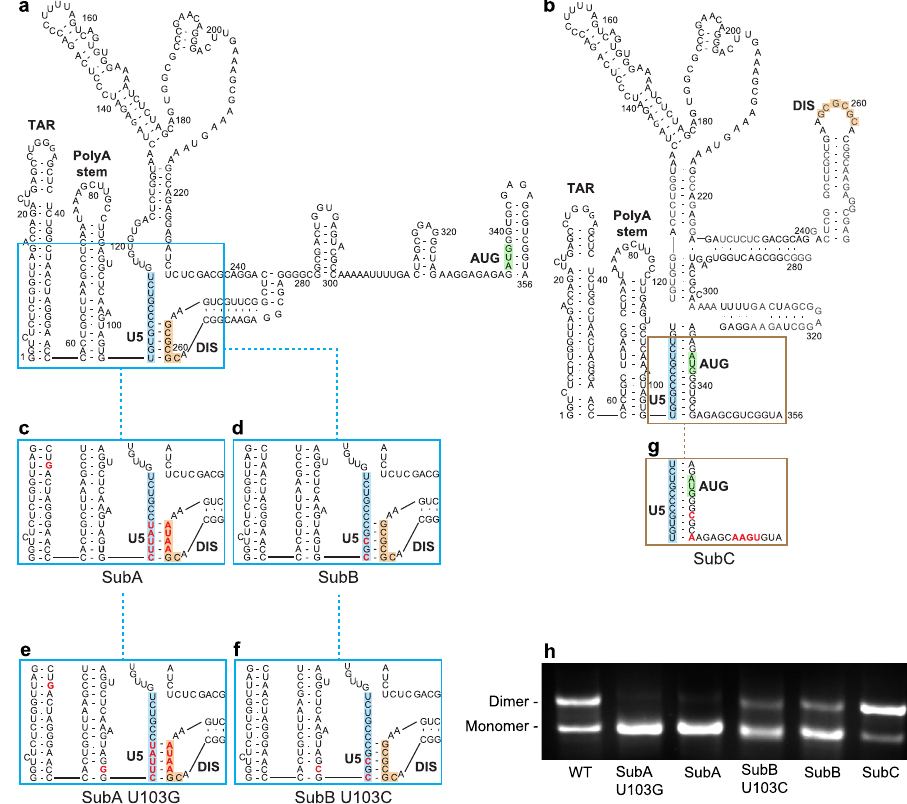
Figure 1. Models of the HIV NL4-3 5 ′ UTR conformations with select nt substitutions to alter monomer-dimer equilibrium. Models of HIV NL4-3 5 ′ UTR ( + 1 to 356) ( a ) monomer and ( b ) dimer structures from Lu et al . 10 . Labels designate: TAR, PolyA stem, U5 (blue), DIS (orange), AUG (green), and nt substitutions (red). Boxes highlight sequences proximal and distal to U5 involved in monomer (blue) or dimer (brown) conformations. ( c and d ) SubA and SubB contain nt changes that favor U5:DIS base-pairing and destabilize U5:AUG base pairing. ( e and f ) Additional U103 substitutions destabilize the bottom stem of PolyA in SubA U103G and SubB U103C. ( g ) SubC contains nt substitutions that favor U5:AUG base-pairing and maintain amino acid conservation without rare codon bias. ( h ) Native agarose gel assay shows 5 ′ UTR conformations in vitro at equilibrium. WT 5 ′ UTR migrated as a mixture of monomer and dimer. SubC mainly migrated as dimer, whereas each of the other 5 ′ UTR variants mainly migrated as